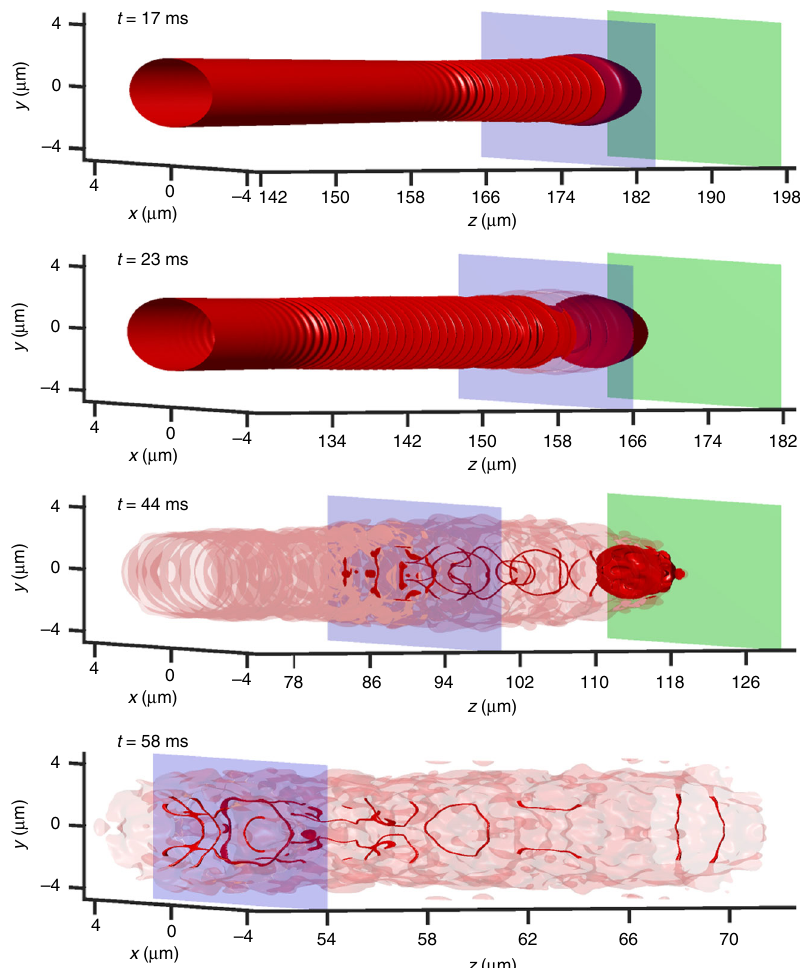
Fig. 4 Isosurfaces of 3D numerical simulation. A piston front (rightmost, non-transparent green plane) sweeping into an elongated BEC at v p = 2.44mms − 1 . The shock front (leftmost, blue transparent plane) propagates through the BEC over time. At time t = 58ms, only the shock front plane is shown. In the plateau region between the two planes, vortex tangles are generated. The isosurface density value is 0.1 ⋅ Γ , semi-transparent for